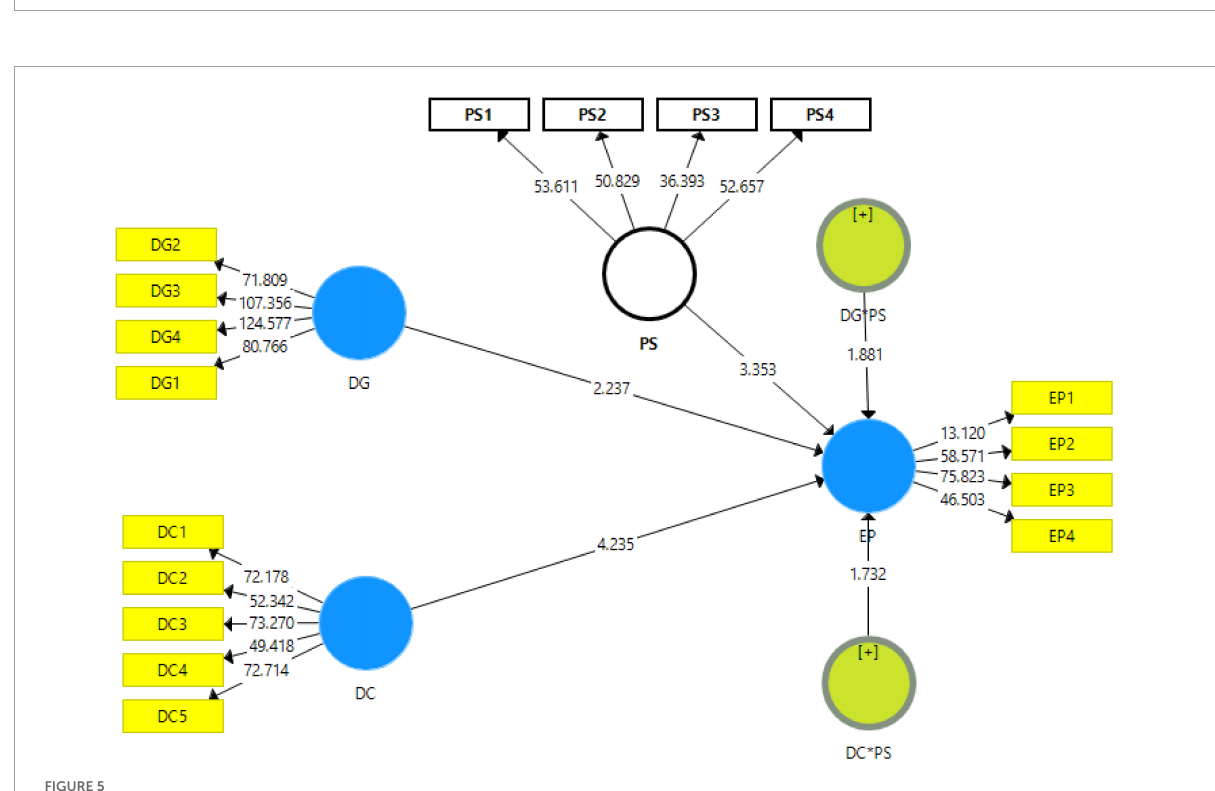
FIGURE5 Structural model